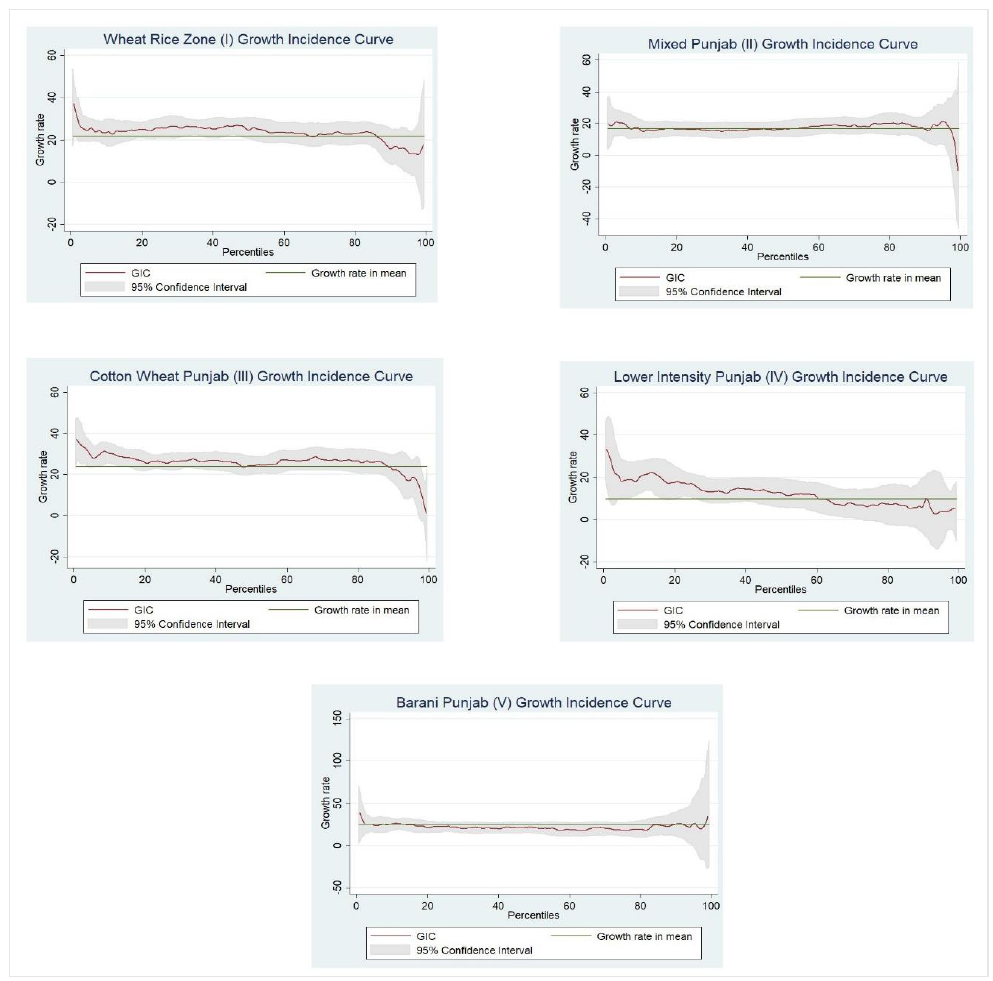
Figure 3. Growth incidence curve for non-farming communities across all agro_climatic zones in Punjab. Table 2. PEGR in agro-climatic zones of Punjab from 2001–2002 to